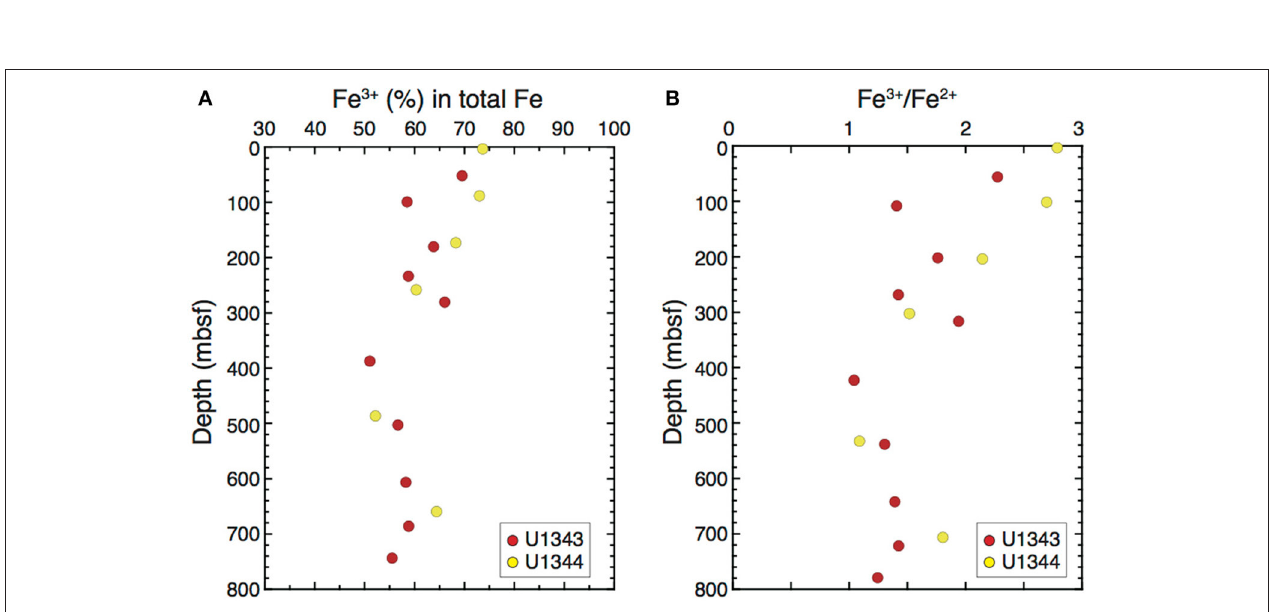
FIGURE 10 | Vertical profile of the relative abundances of (A) Fe 3 + in total Fe and (B) Fe 3 + /Fe 2 + in the clay-size fraction at Sites U1343 and U1344 determined by 57 Fe Mössbauer